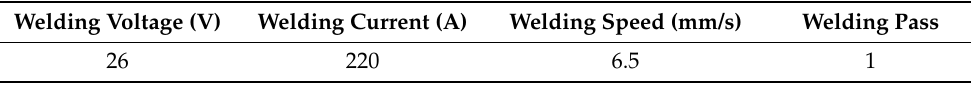
Table 3. Welding parameters of Q460 low-carbon steel butt